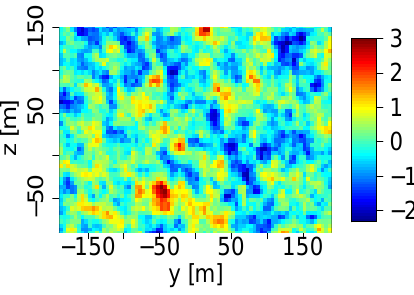
Figure 20. Homogeneous turbulent field: A spectral surrogate from the central wake region marked by the black circles in Figures 1c and